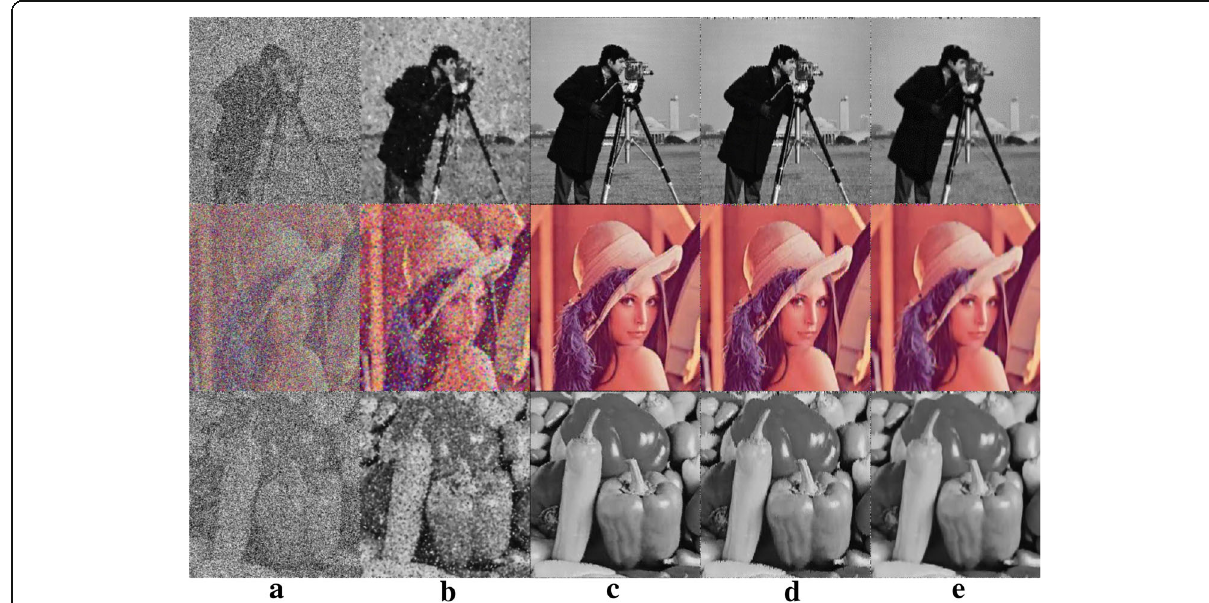
Fig. 3 Performance of a RF ( λ = 0.25), b AMD ( λ = 0.25), c AADF ( λ = 0.25), d FORADF ( λ = 0.25), and e FORADF ( λ = 1) for salt and pepper noise at 70% density. λ represents the control parameter, and n represents the number of iterations